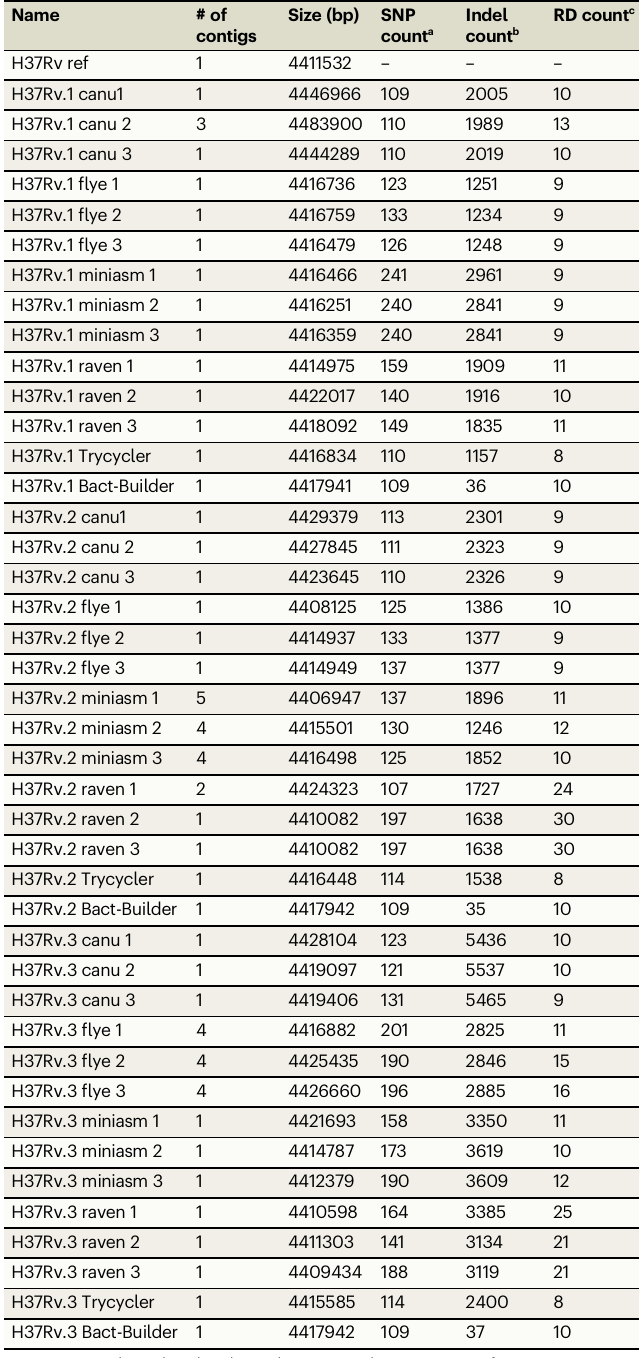
Table 1 | H37Rv.1-3 individual assembly results, and DNAdiff analysis comparing individual assemblies to the H37Rv reference (H37Rv